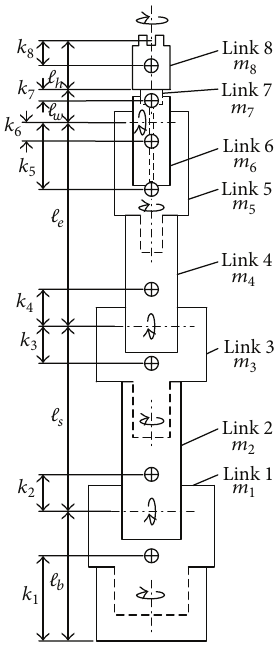
Figure 7: Link parameters of 7-DOF manipulator.